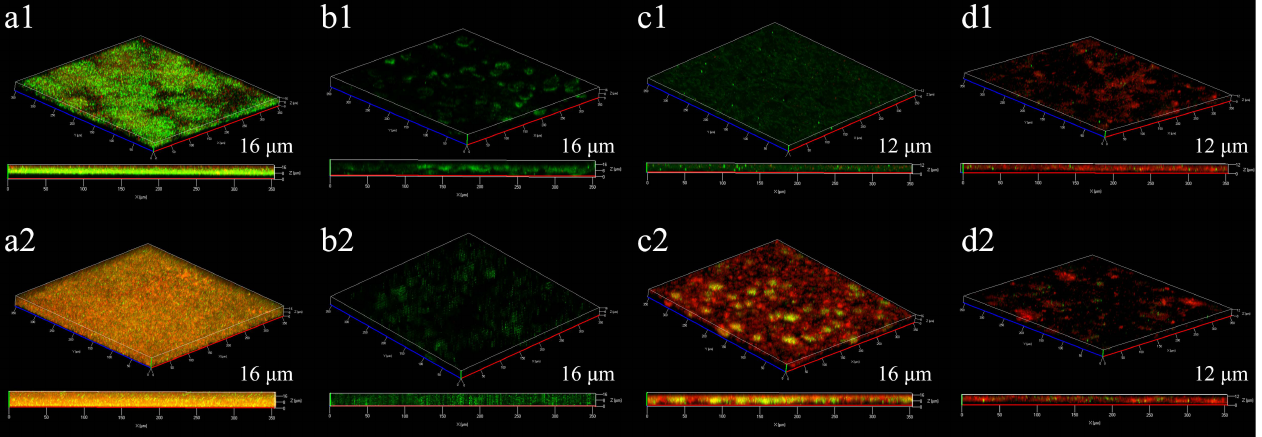
Figure 2. CLSM images of mixed biofilms on EH40 steel after 7 ( a1 – d1 ) and 14 days ( a2 – d2 ) of immersion in different systems: ( a1 , a2 ) full system without nitrate addition; ( b1 , b2 ) starvation system without nitrate addition; ( c1 , c2 ) full system with nitrate addition; and ( d1 , d2 ) starvation system with nitrate